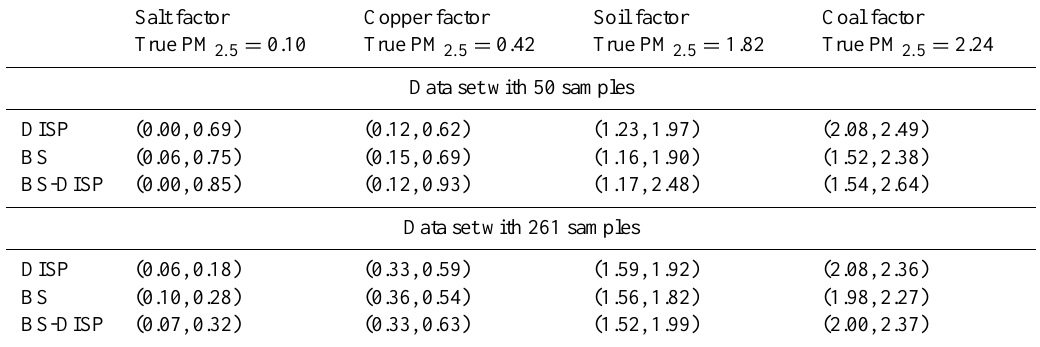
Table 2a. Lower and upper interval estimates of PM 2 . 5 (µgm − 3 ) by factor for Case 2 (realistic errors) for data sets with 50 or 261 samples.